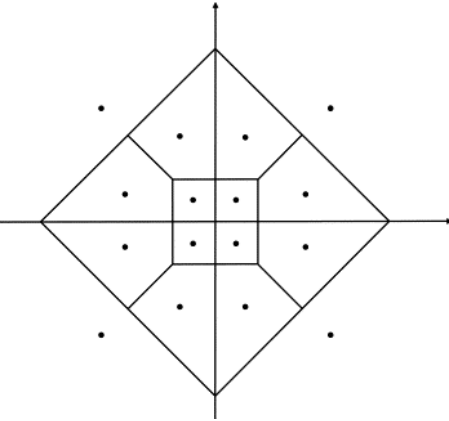
Figure 6. Example of Voronoi regions and their associated centroids (points).